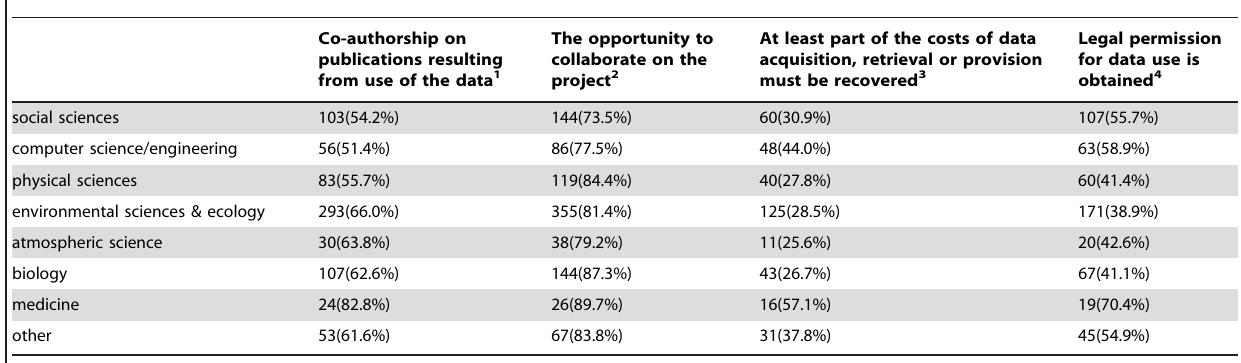
Table 22. Using others’ data by subject